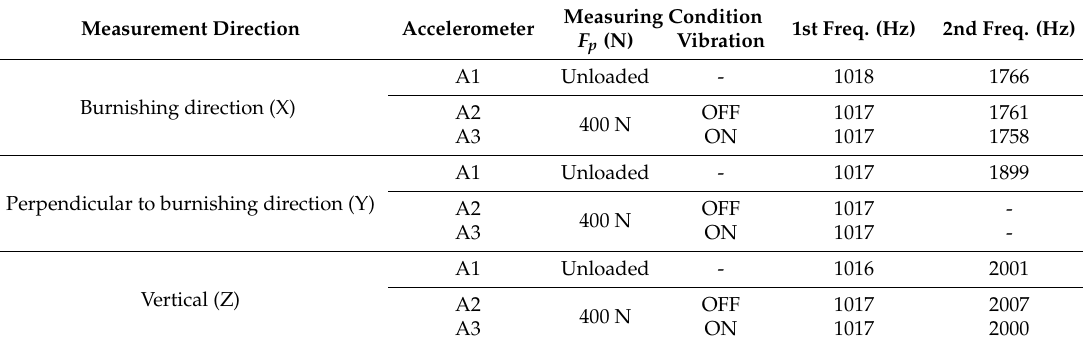
Figure 6. FRF and Bode diagram obtained by A3 accelerometer (vertical direction) after impact test on the unloaded workpiece. Table 5. Natural frequencies obtained through impact tests on the workpiece through vertical impacts and machine-tool